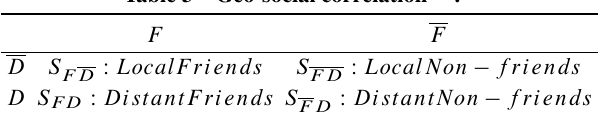
Table 3 Geo-social correlation [59] . F F W LocalF riends S W LocalNon (cid:0) f riends D S FD FD